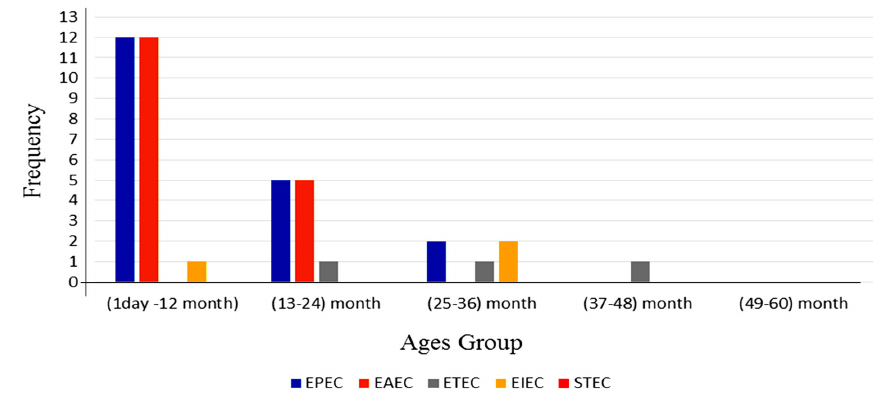
Fig.1. Prevalence diarrheagenic E. coli with age